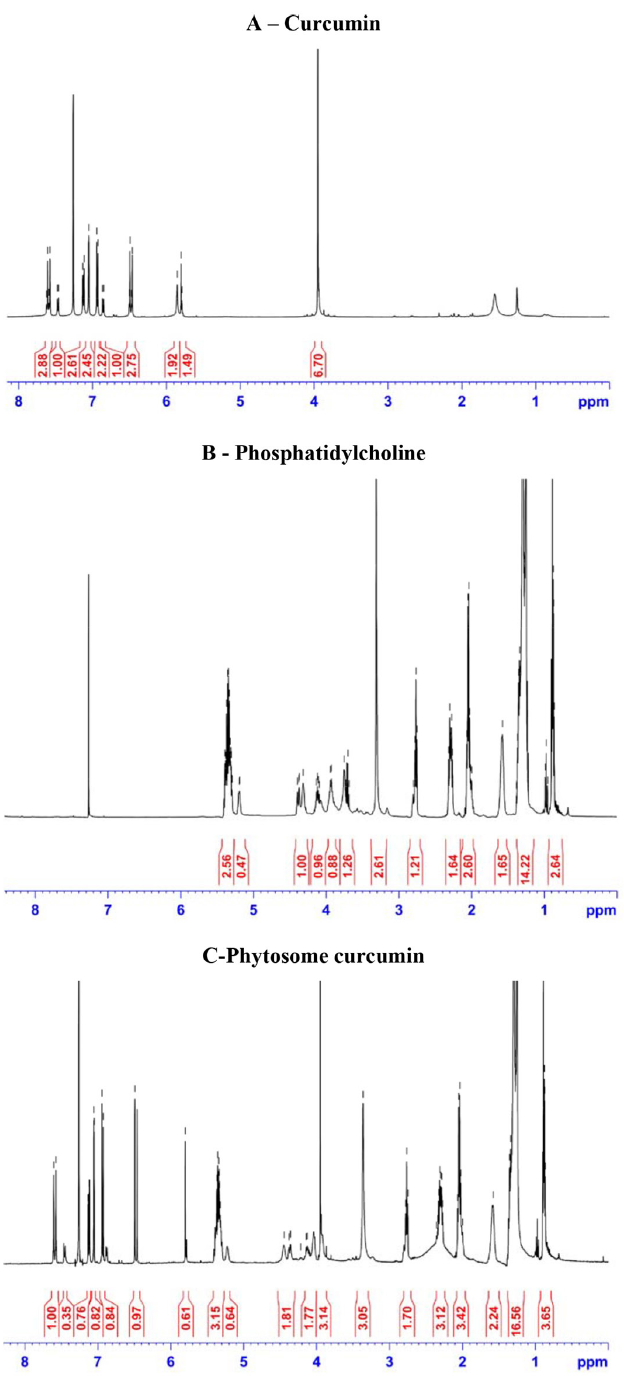
FIGURE 7 - Proton NMR Spectrum of Curcumin (A), Phosphatidylcholine (B) and Phytosome curcumin